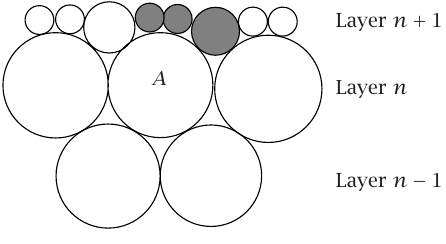
Figure 2.3. The shaded circles are the o ff spring of circle A